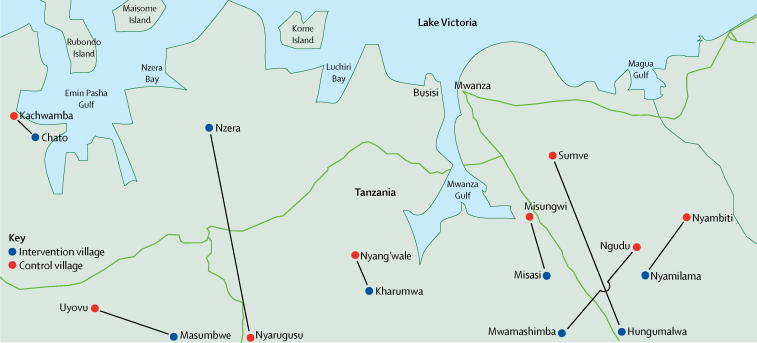
Intervention and control villages selected for the cluster randomised trial in northwest TanzaniaIntervention villages, shown in blue, were paired with control villages, shown in red, by proximity (within 60 km) and timing of the male circumcision outreach campaign. Black lines on map indicate paired villages.